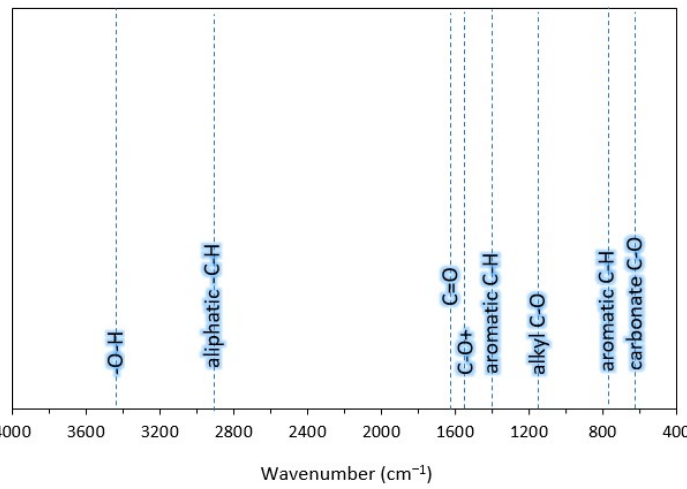
Figure 1. Fourier transform infrared (FTIR) spectra of wheat straw biochar.